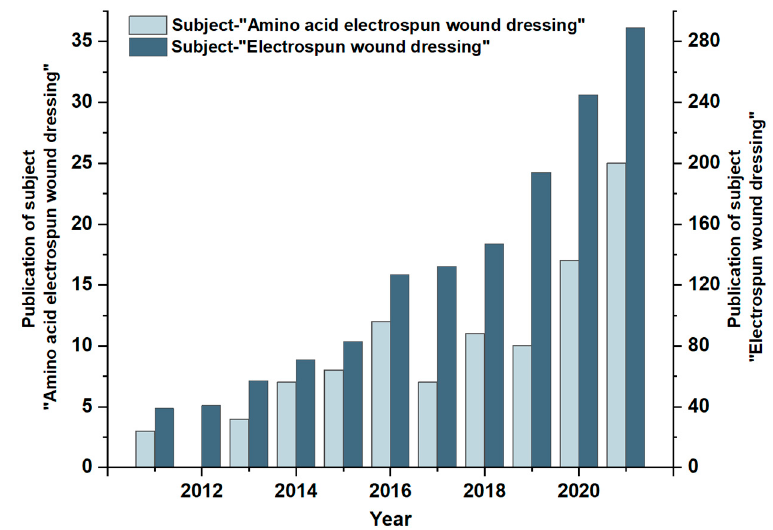
Figure 3. Statistics of literature retrieval on the “Web of Science” platform with the subject of “Electrospun wound dressing” and “Amino acid electrospun wound dressing”, respectively.